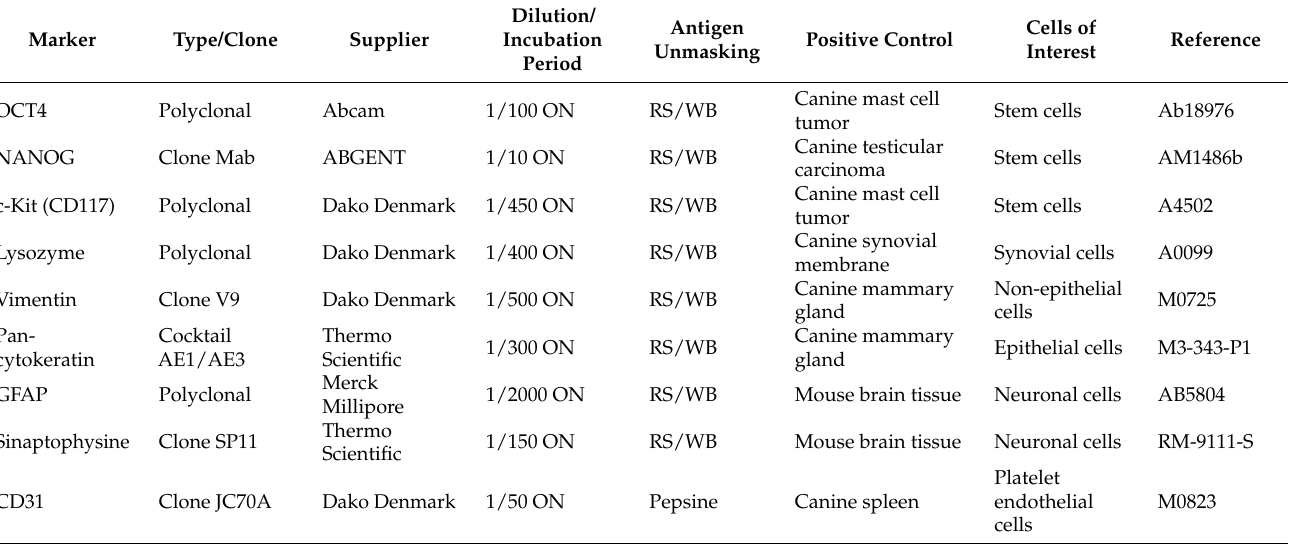
Table 3. List of antibodies investigated, dilutions, and antigen retrieval methods applied in the im- munohistochemical analysis. Oct 4—Octamer-binding transcription factor 4; NANOG—Homeobox protein NANOG; GFAP—Anti-Glial Fibrillary Acidic Protein; CD31—Platelet endothelial cell adhe- sion